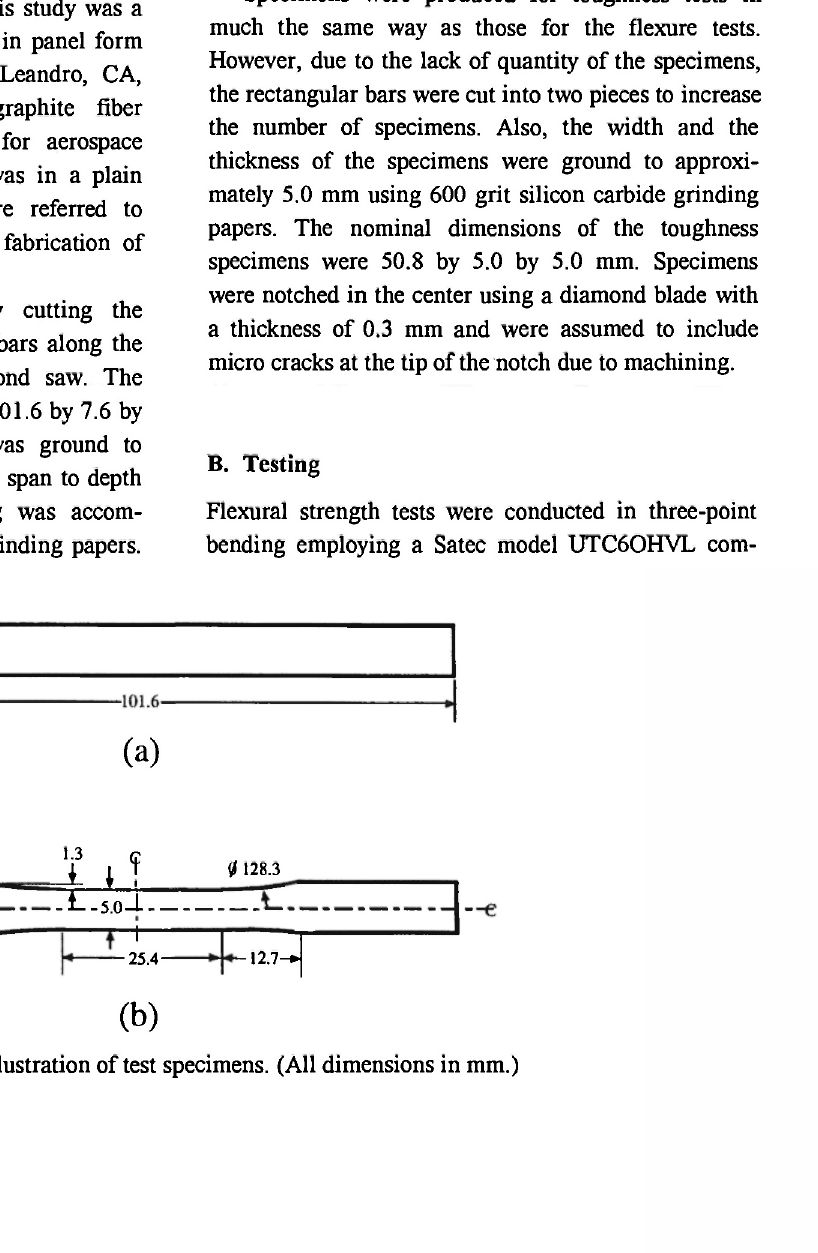
Fig. 1: Schematic illustration of test specimens. (All dimensions in